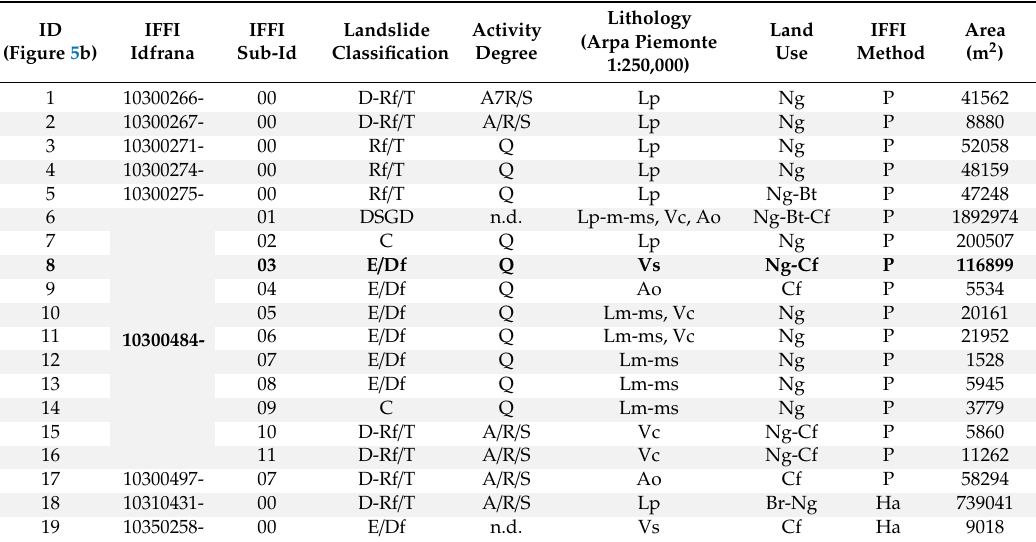
Table 2. Landslides located along the investigated slope and included in the IFFI database ( Activity degree codes : A = Active; R = Reactivates: S = Suspended; Q = Quiescent; n.d. = not